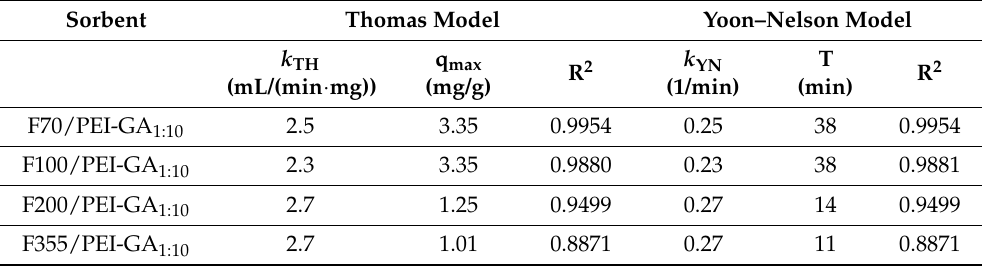
Table 3. Parameters of dynamic sorption of Cu 2+ onto sand composites determined by Thomas and Yoon–Nelson models.